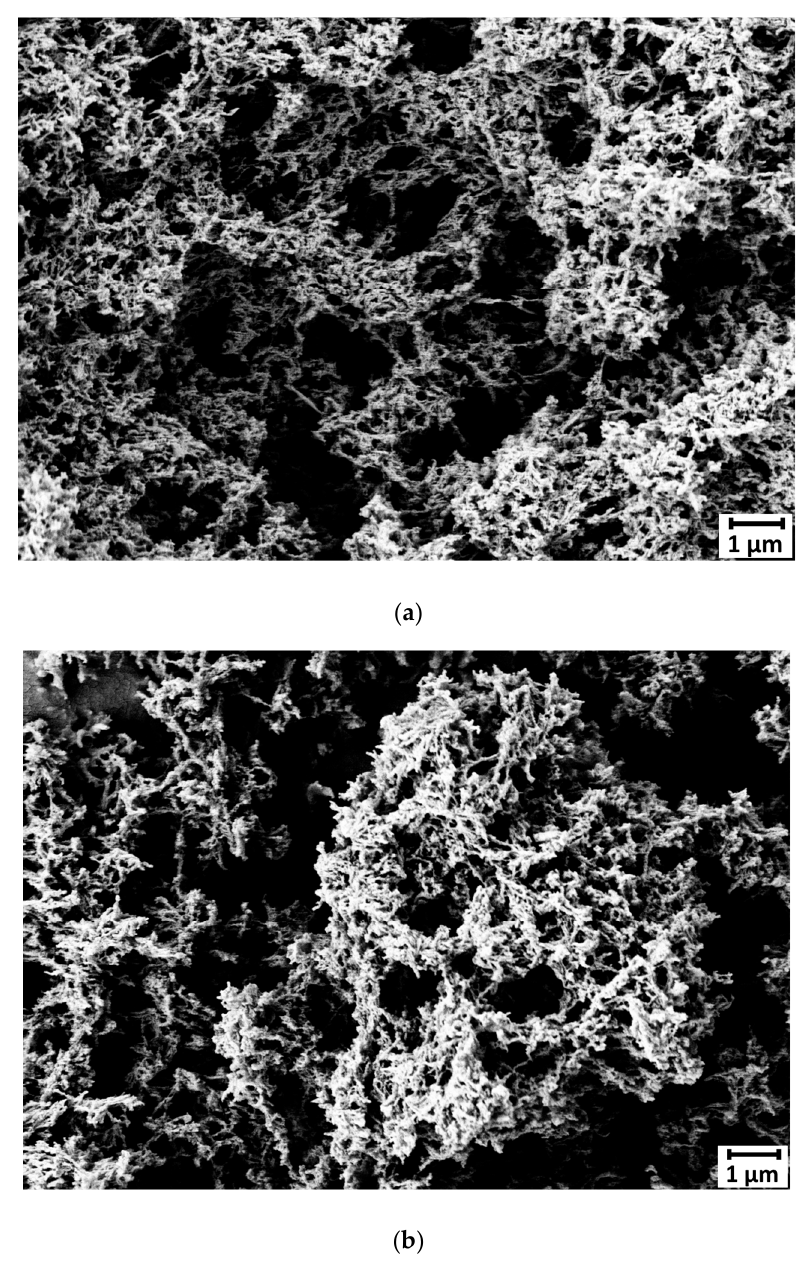
Figure 6. Scanning Electron Microscopy (SEM) images of samples ( a ) S 7.5 _WA 70 and ( b ) S 7.5 _WA 80 .